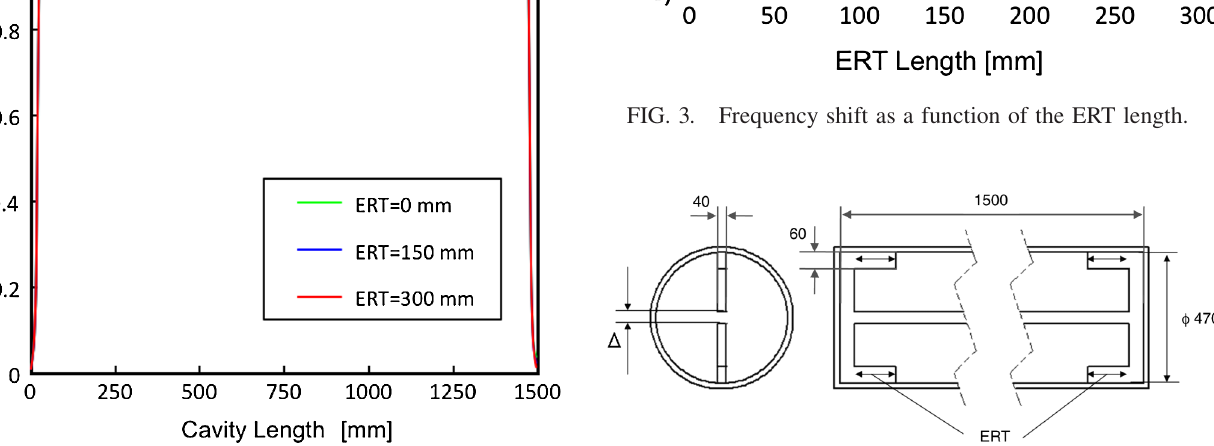
mm).FIG. 2. Transverse electric field strength on 1-A for the TE